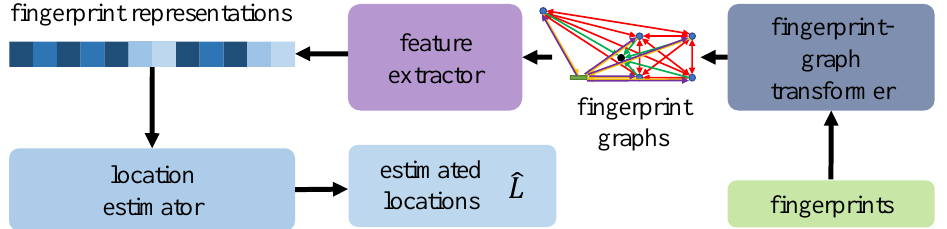
Figure 10. The online inference pipeline of our proposed system.